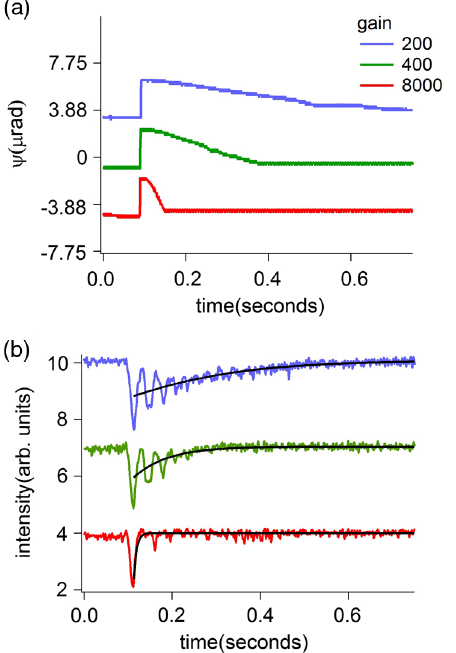
FIG. 3. (a) Unencoded HFM piezo steering angle set value and (b) sample intensity convergence times as a function of feedback gain. Curves have been offset for clarity. The convergence time decreases with increasing feedback gain. The 30 Hz oscillations in the diode intensity are due to the HFM mechanical resonance at 30 Hz that is excited by applying a step deflection to the HFM steering angle set value. The black curves are best fits to an exponential.